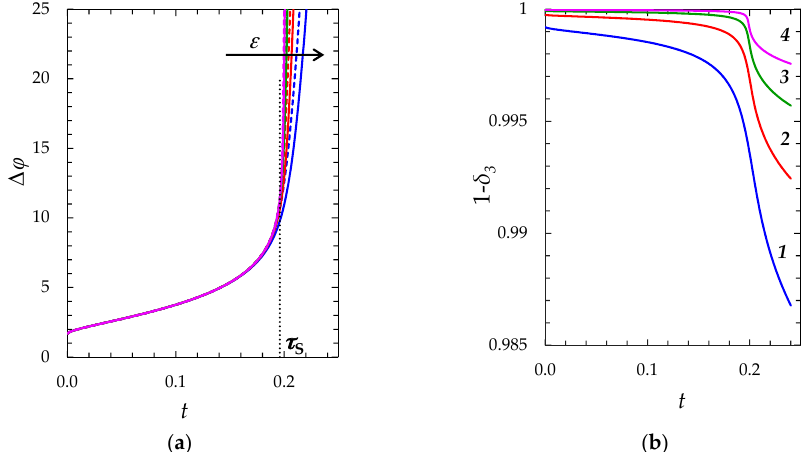
Figure 7. ( a ) Chronopotentiograms calculated using the “zonal” model (solid lines) and the “simplified” model (dashed lines), τ S = 0.196 is the transition time determined using the Sand formula, Equation (18); ( b ) time dependence of the dimensionless thickness of the first zone (1 − δ 3 ) found using the “zonal” model. The calculations are carried out at i / i lim = 2 for the following values of ε : 3 × 10 − 7 (1); Table 1. Estimation of the deviation between the calculations of the time at which ∆ ϕ = 20 when using the “zonal” and the “simplified” models for the different values of ε . с 0 , The Time at Which ∆ ϕ = 20 Deviation, mol/m 3 | (cid:101) t ε zon − (cid:101) t simpl γ =